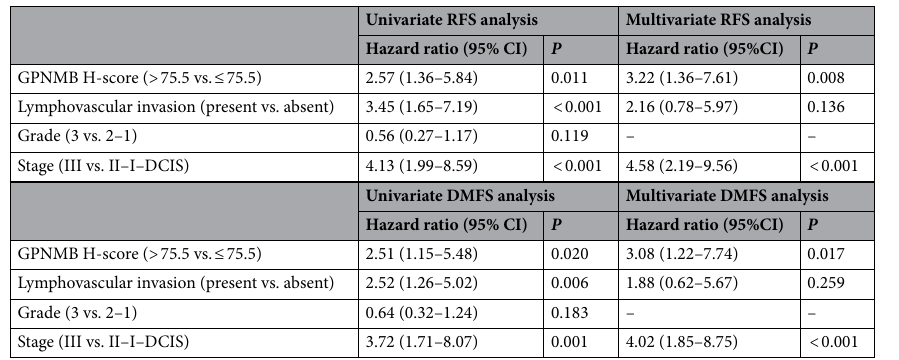
Table 3. Univariate and multivariate Cox analysis of factors associated with recurrence free survival (RFS) and distant metastasis-free survival (DMFS) in patients with